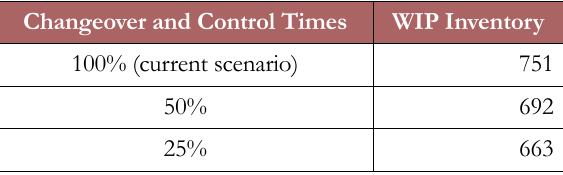
Table 6. SMED effect on